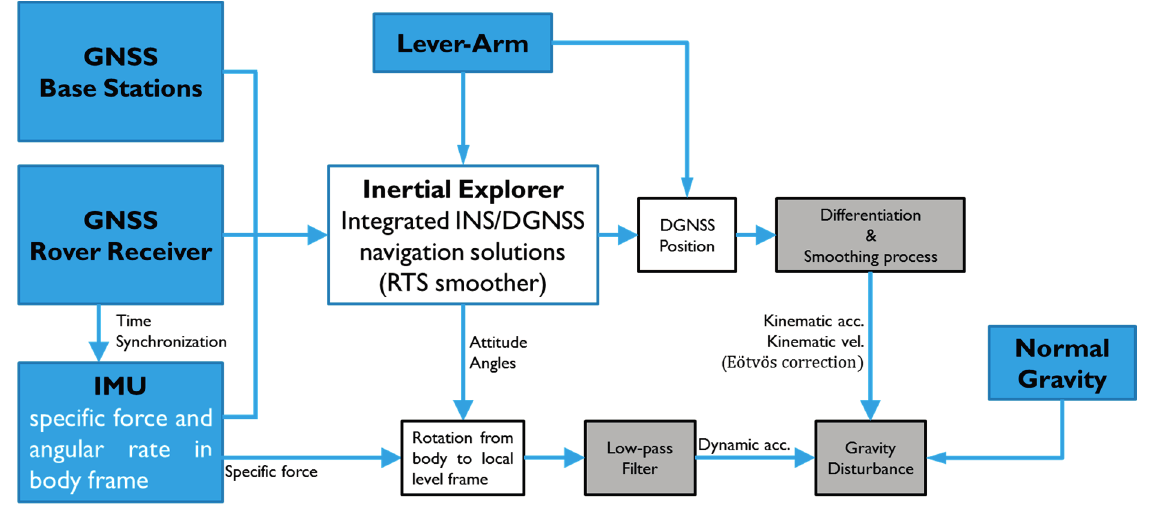
Figure 4. Data processing flowchart of the proposed SINS/GNSS